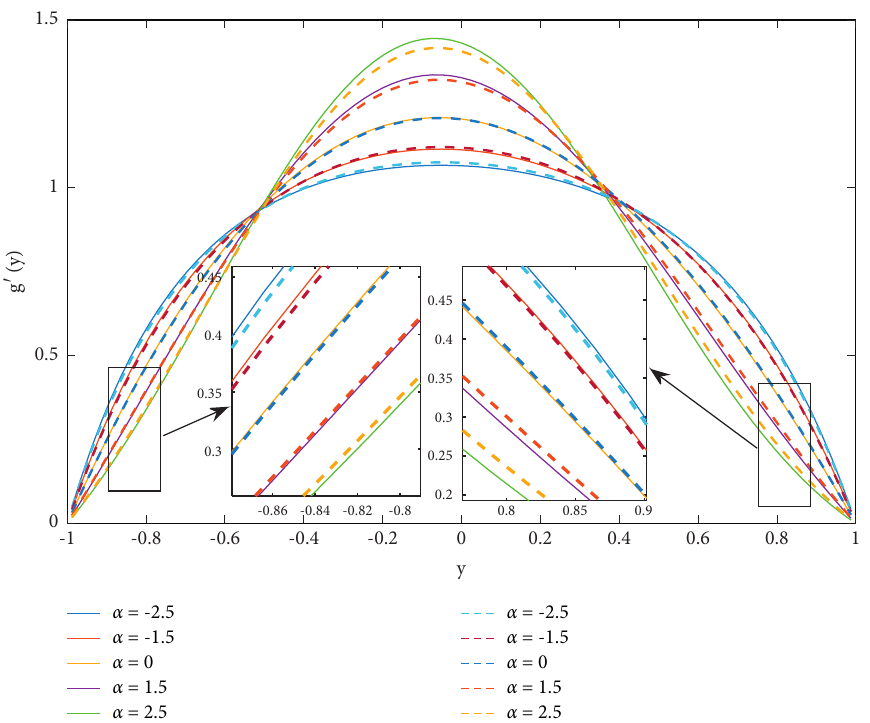
Figure 7: Impact of RC ratio α over profile g ( 1 ) ( y ) for SWCNTs (dashed lines) and MWCNTs (concrete lines) via S2HWs for the parameters A ∗ � 0 . 2 , φ � 0 . 1 , R � −